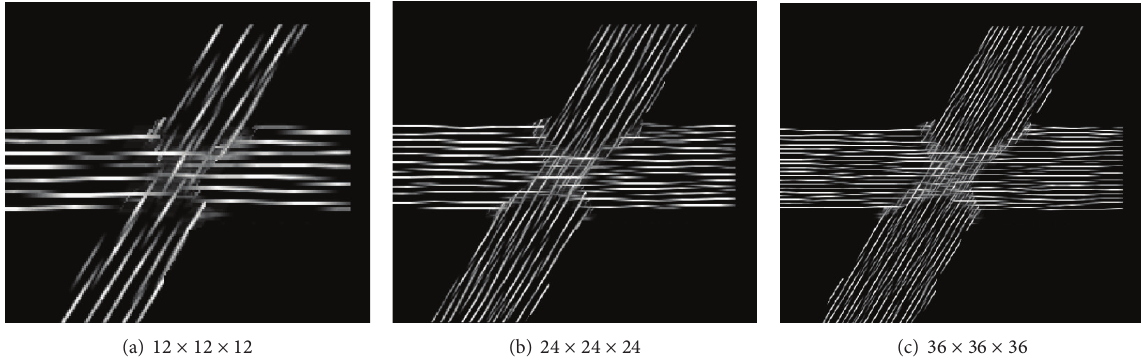
Figure 10: Influence of grid resolution on the LIC result using a resolution factor of (a) 1/12 , (b) 1/24 , and (c) 1/36